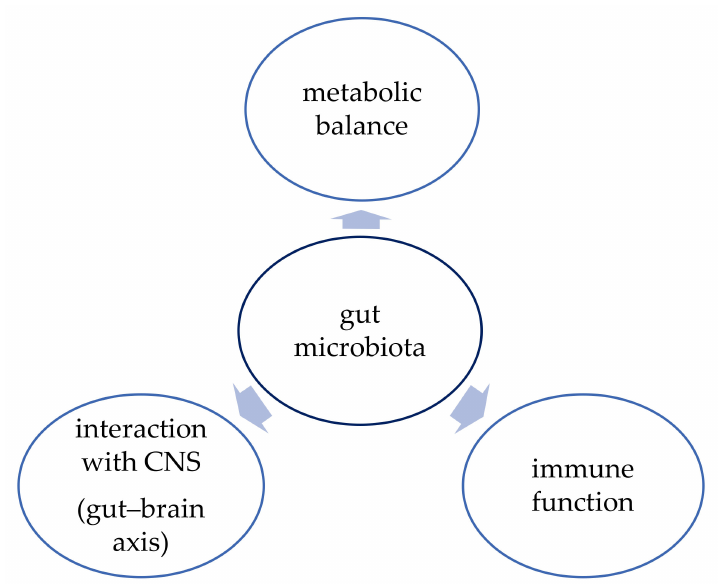
Figure 1. Function of gut microbiota